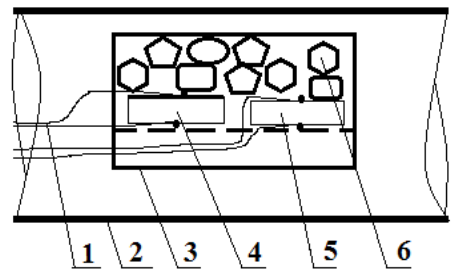
Figure 5. A scheme of the experimental setup. 1—thermocouples, 2—furnace, 3—metal cylinder, 4—coated sample, 5—sample without coating, 6—straw pellets.